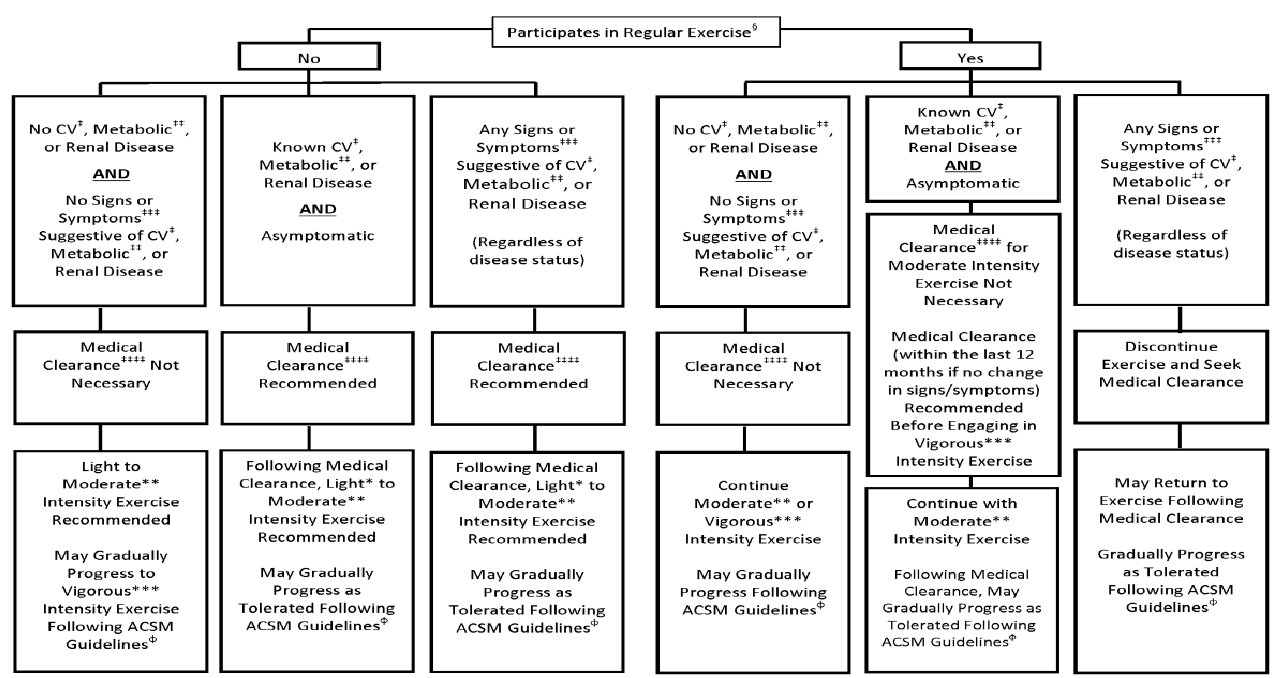
Figure 6. ACSMs recommendations for exercise preparation health screening [17]. §: Exercise participation, performing planned, structured physical activity at least 30 min at moderate intensity on at least 3 days per week for at least the last 3 months. *: Light-intensity exercise, 30% to G40% HRR or V ̇ O2R, 2 to G3 METs, 9–11 RPE, an intensity that causes slight increases in HR and